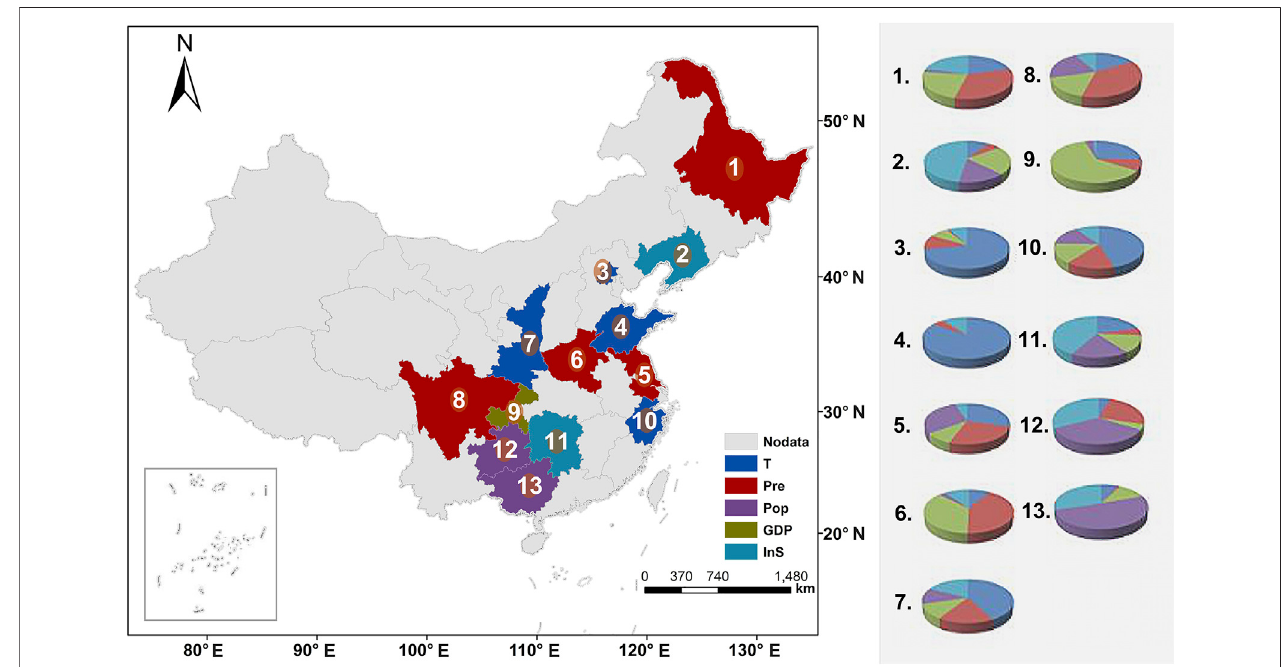
FIGURE9| Spatialdistributionofthemainfactorsaffectingthephenologyofurbanplantsintheregion.Differentcolorsintheleft fi gureindicatethemainin fl uencing factors of urban plant phenology in this subregion. The numbers in the fi gure on the right correspond to the subregions in the fi gure on the left, and each number corresponds to the pie chart to represent the contribution of each in fl uencing factor affecting urban plant phenology in this region.